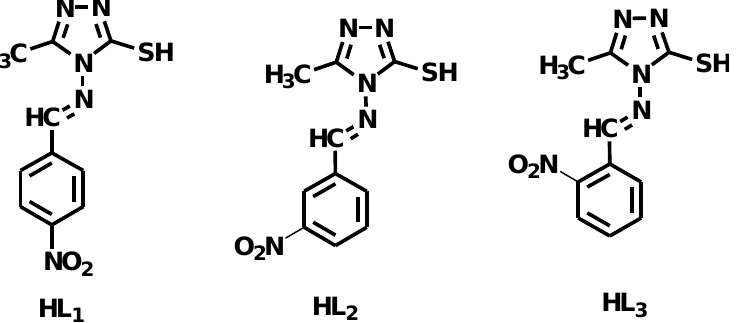
Figure 1. The molecular structures of triazol-based Schiff base ligands (HL 1 – HL 3 ).